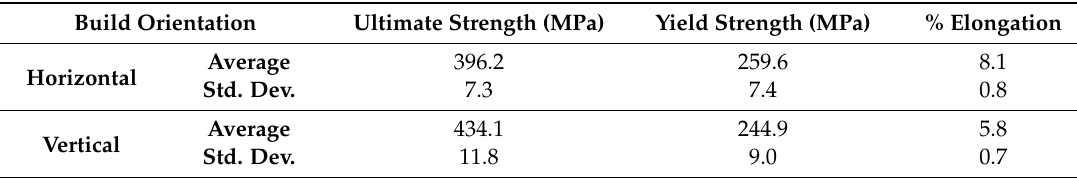
Table 2. Results from tensile testing campaign for Case Study